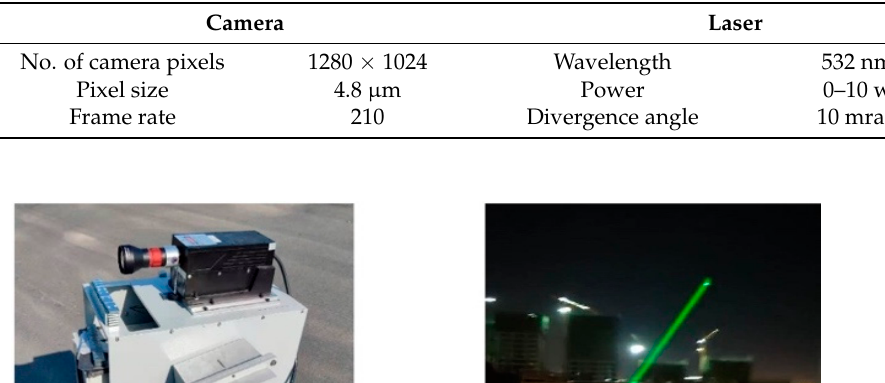
Table 2. Experimental parameters.